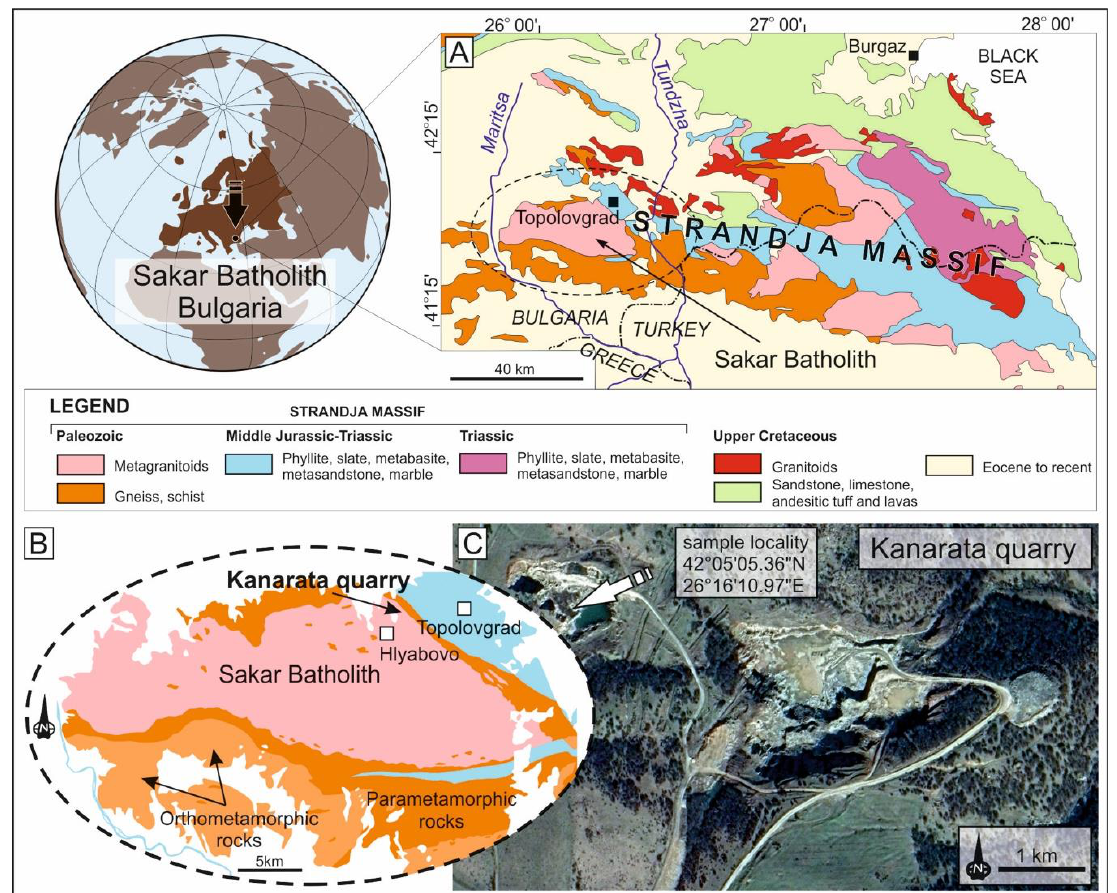
Figure 1. The Sakar Mountains in Bulgaria—study area: ( A ) geological map of the Strandja Massif (Southeast Bulgaria) and neighboring regions; ( B ) geological sketch map of the Sakar Unit (modified after [10,11]); ( C ) Kanarata quarry—sample locality.